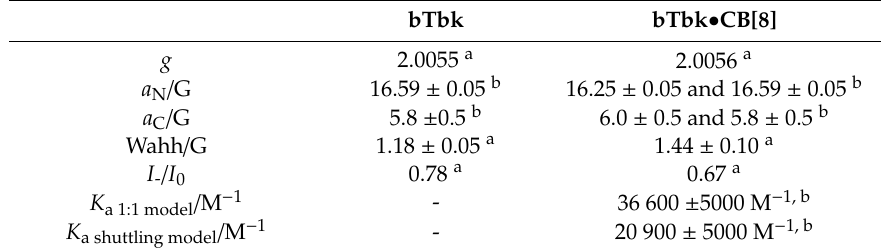
Table 2. EPR parameters for bTbk and for the bTbk • CB[8] complex. Binding constants based on simulations of EPR spectra (see the